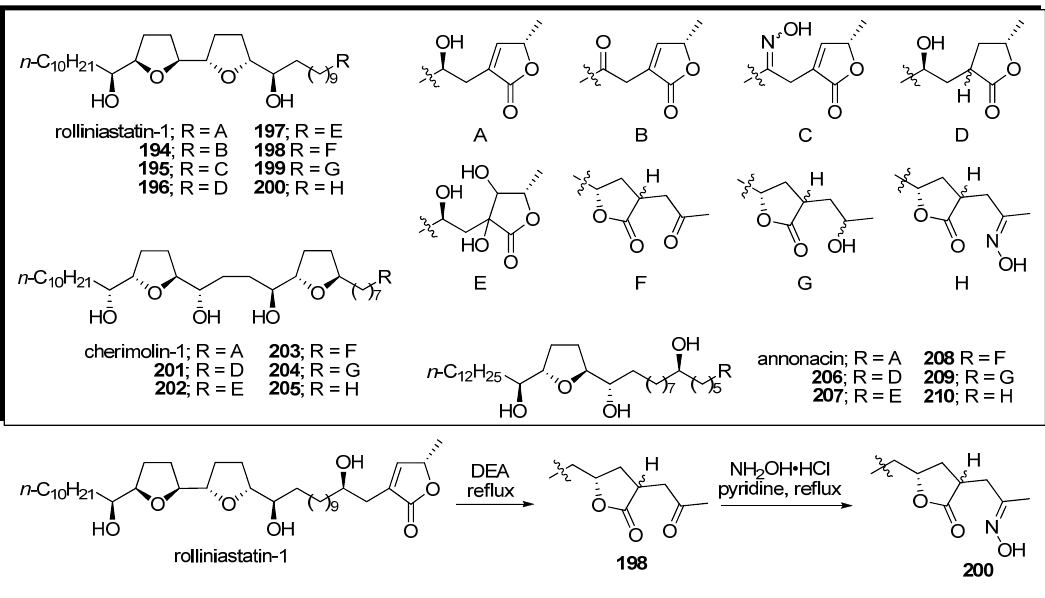
Table 15. Inhibitory potency against complex I.